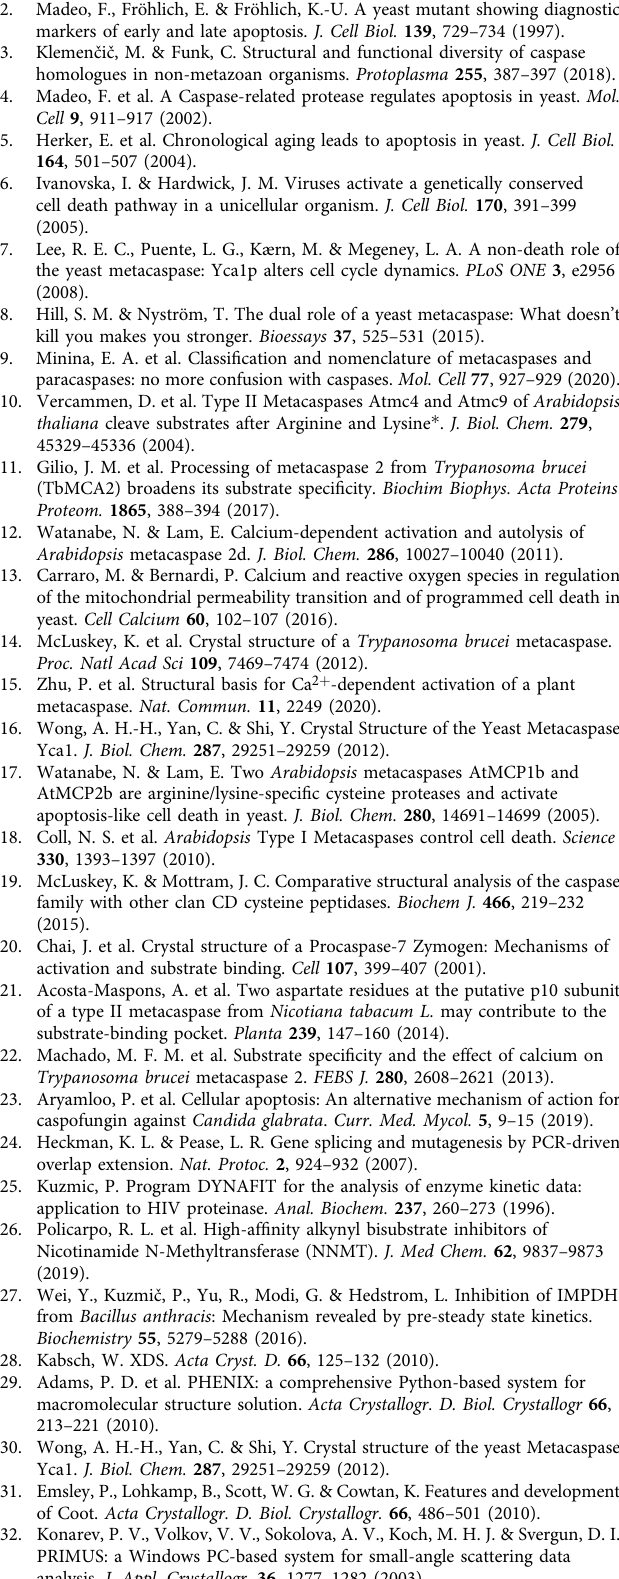
Figure rendering . Figures of three-dimensional structures were drawn with PyMol (Schrödinger,